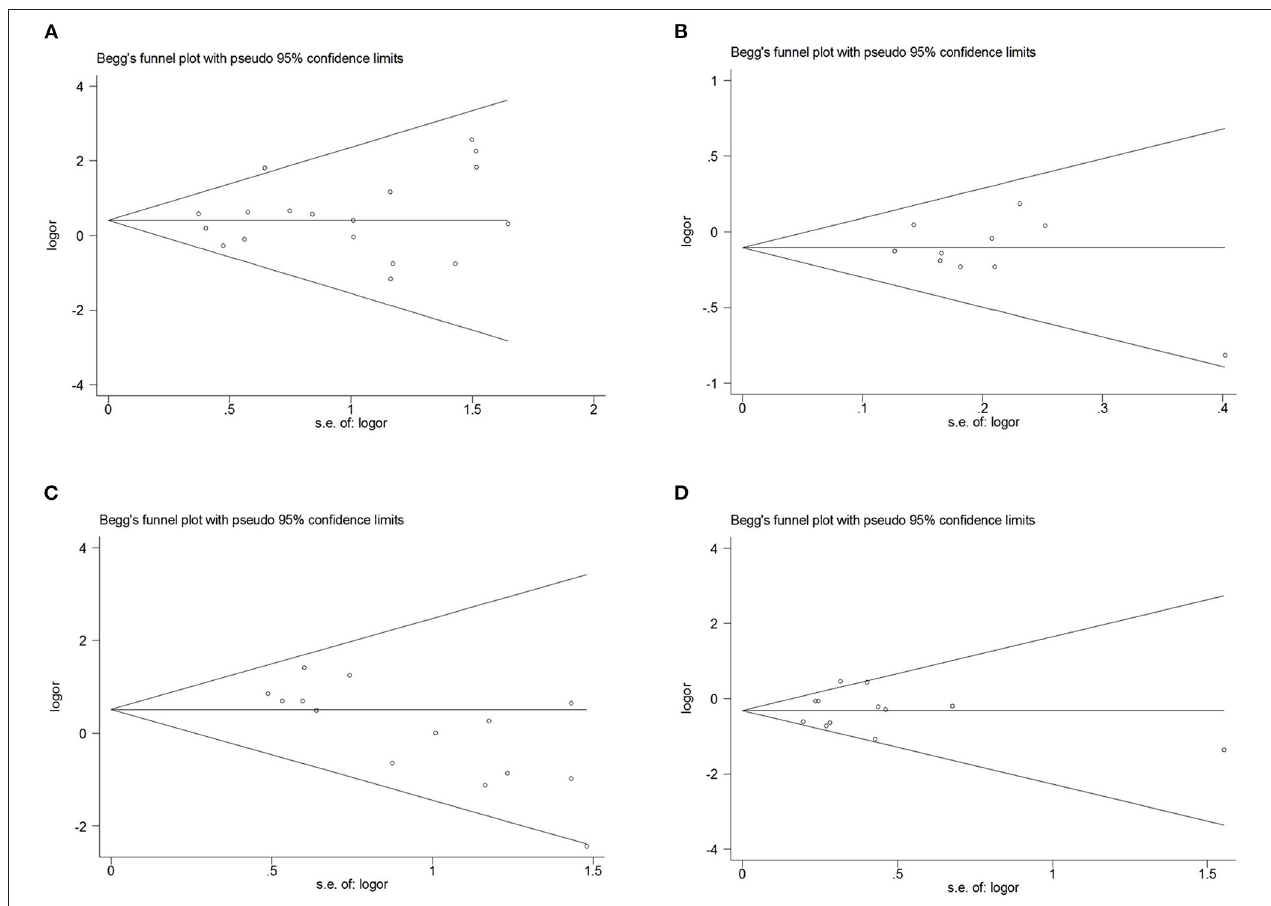
FIGURE 4 | Begg’s funnel plot for publication bias test. (A) , SCN1A rs2298771 polymorphism (GG vs. AA). (B) , SCN1A rs10188577 polymorphism (C vs. T). (C) , SCN2A rs17183814 polymorphism (AA vs. GG). (D) SCN2A rs2304016 polymorphism (G vs.